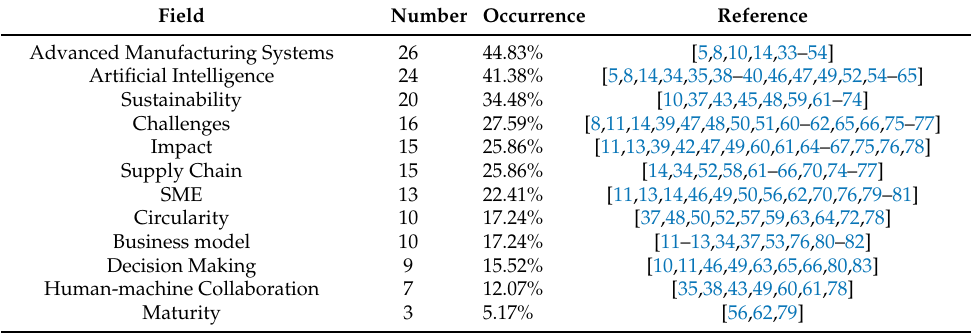
Table 2. Distribution of concepts and technologies obtained by survey articles. Field Number Occurrence